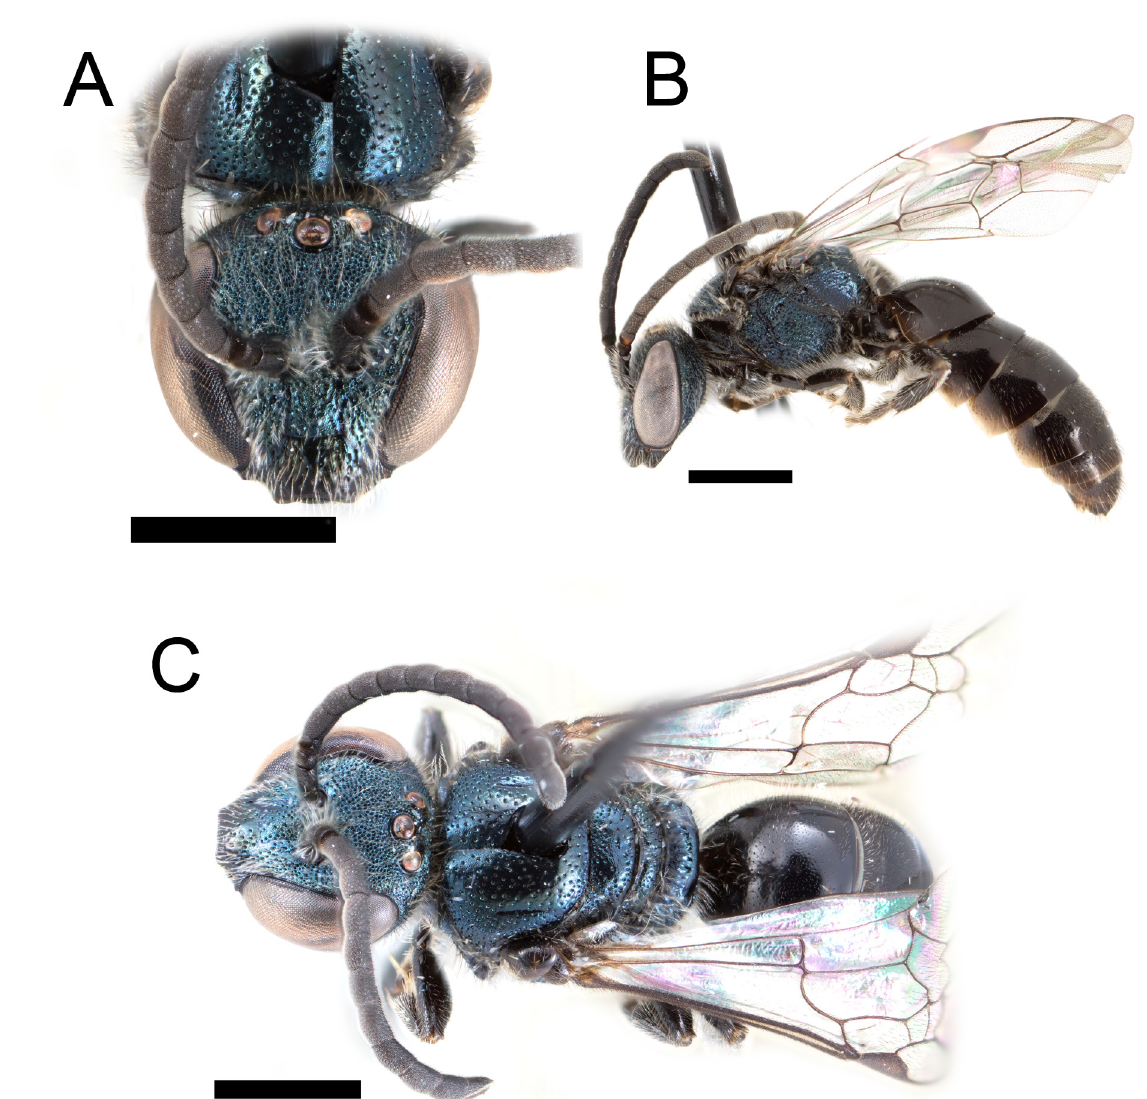
Fig. 19. Lasioglossum genaroi sp. nov., ♂. A . Face. B . Lateral habitus. C . Dorsal habitus. Scale bars = 1